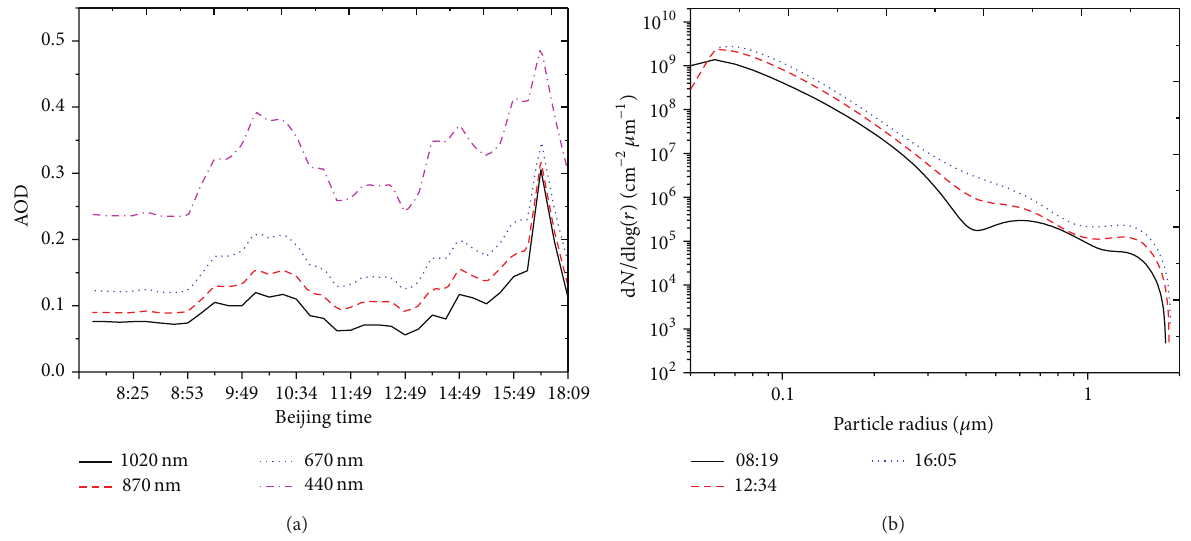
Figure 6: The AOD and size distribution of a sunny day taken on September 19,